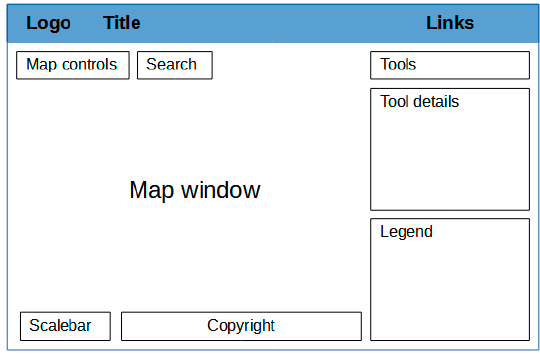
Figure 7. Template of the web map application.